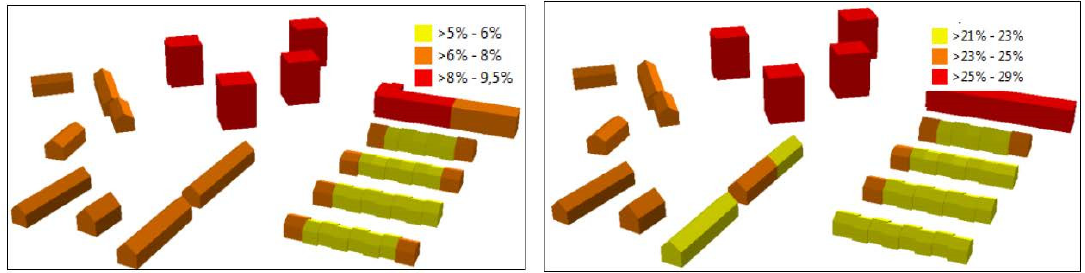
Figure 14. Decrease of annual heating energy needs in 2050 ( left ) and in 2100 ( right ), compared to the reference scenarios.